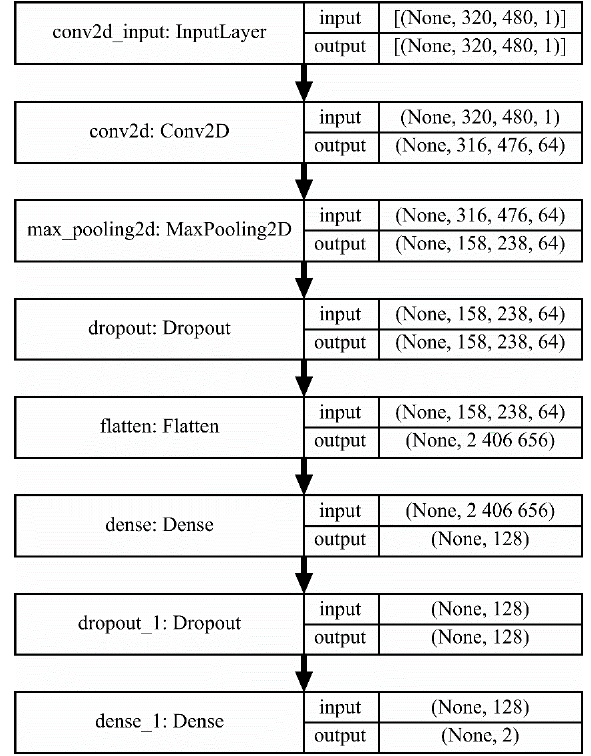
Figure 5. Convolutional neural network (CNN) architecture.